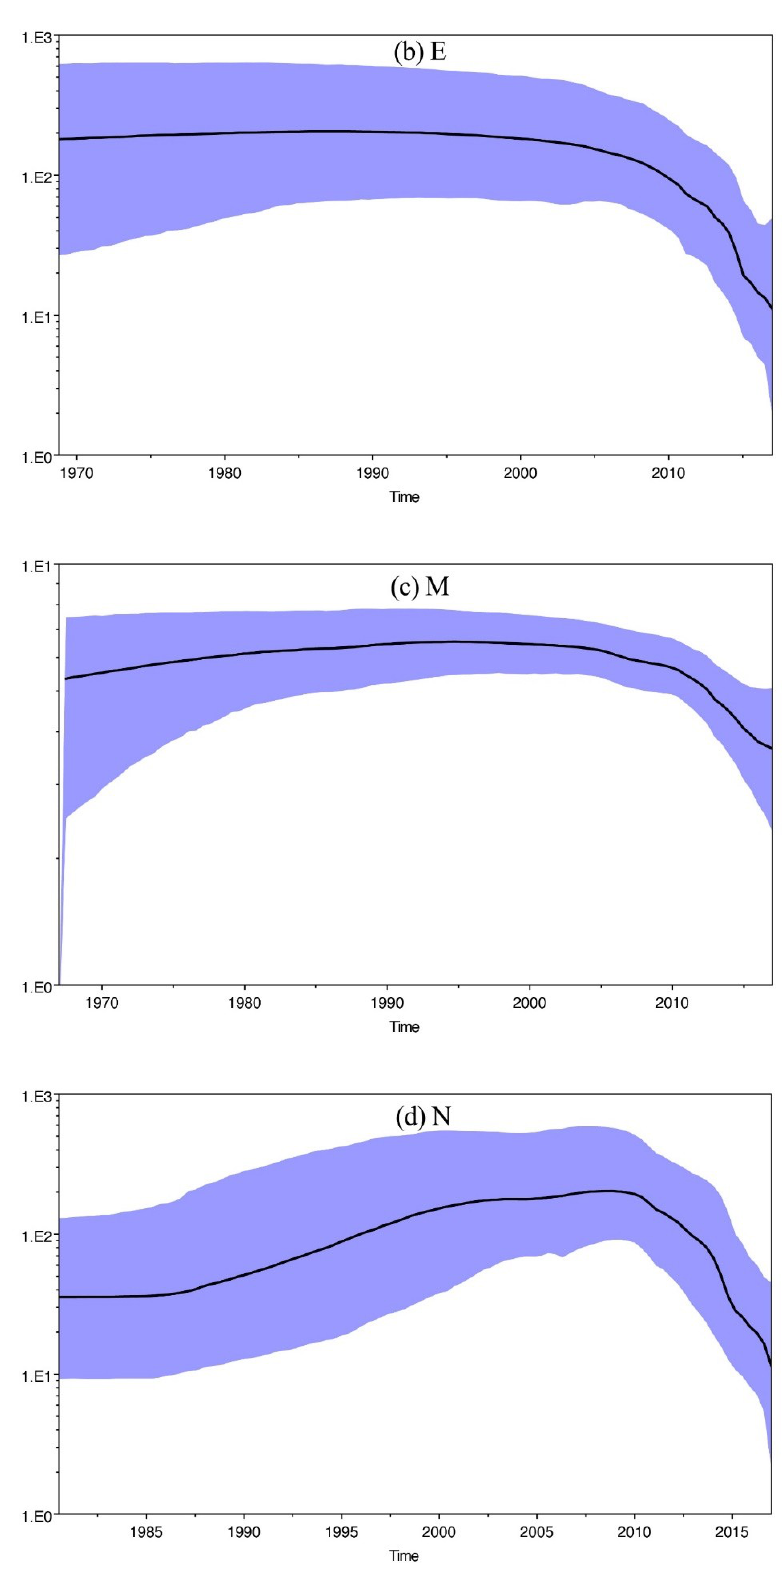
Figure 6. Bayesian skyline plot of ( a ) S1, ( b ) E, ( c ) M, and ( d ) N genes in IBV. The Y -axis represents the effective population size (log10 scale) and X -axis represents generation time (calendar year). The solid black line represents the mean value over time. The 95% HPD intervals are shown in blue region.